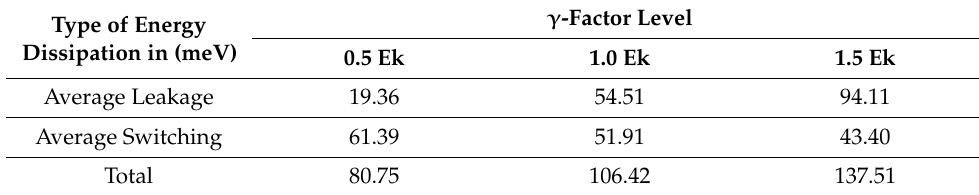
Table 4. Values of energy dissipation for proposed 2-bit PIPO design at different γ -factor levels. Table 5. Values of energy dissipation for proposed 4-bit PIPO design. Type of Energy Dissipation in (meV) Types of